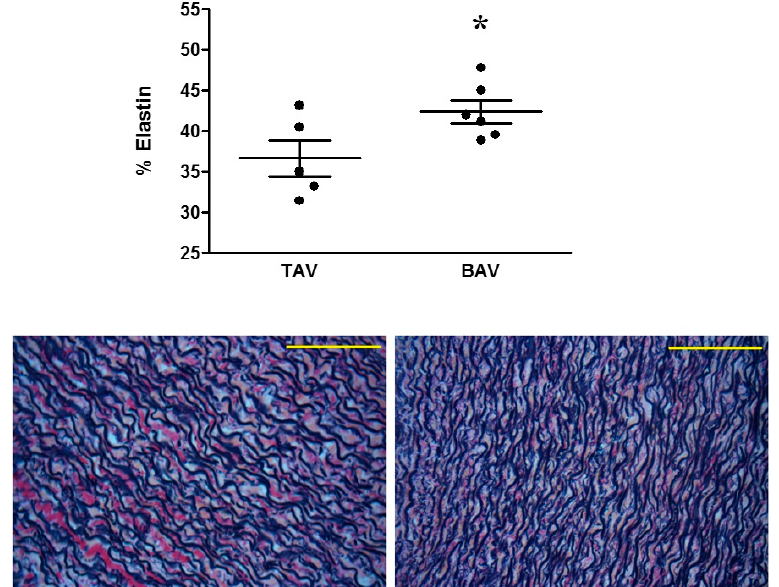
‘Cardiovascular System Development and Function’. #; number.